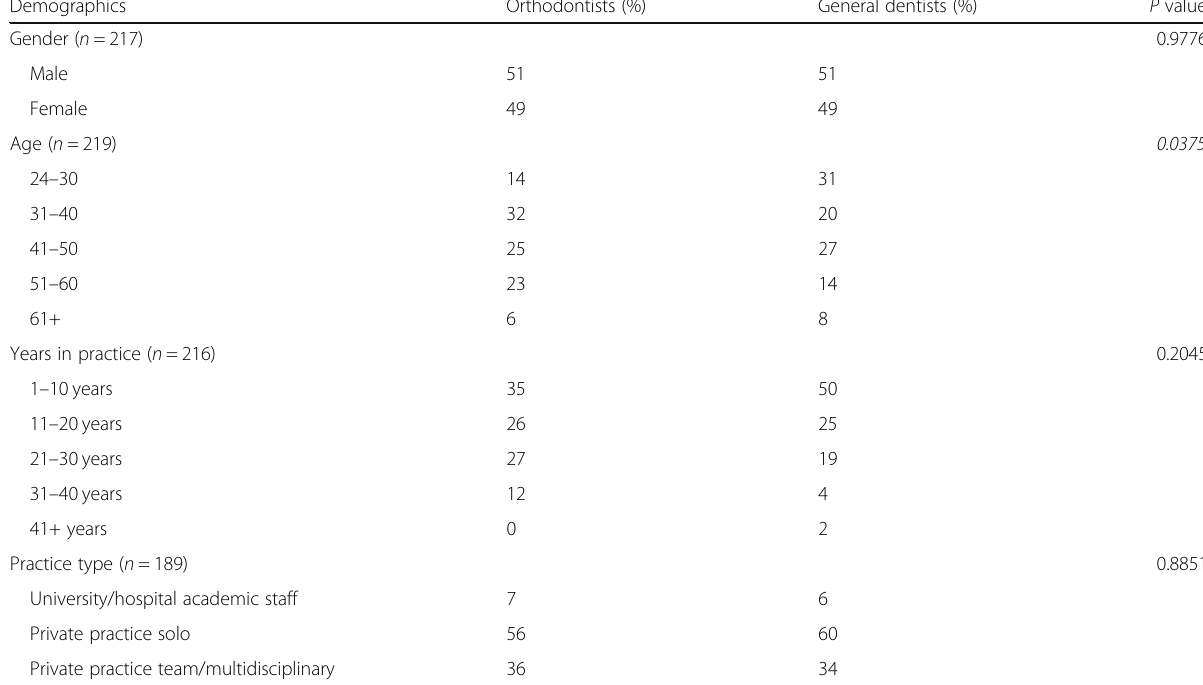
Table 1 Differences between orthodontists and general dentists in demographics